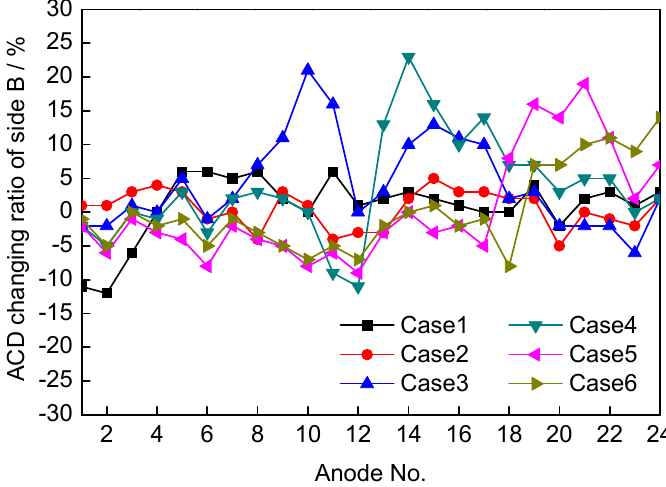
Figure 10. The ACD changing ratios of side B for six abnormal states.